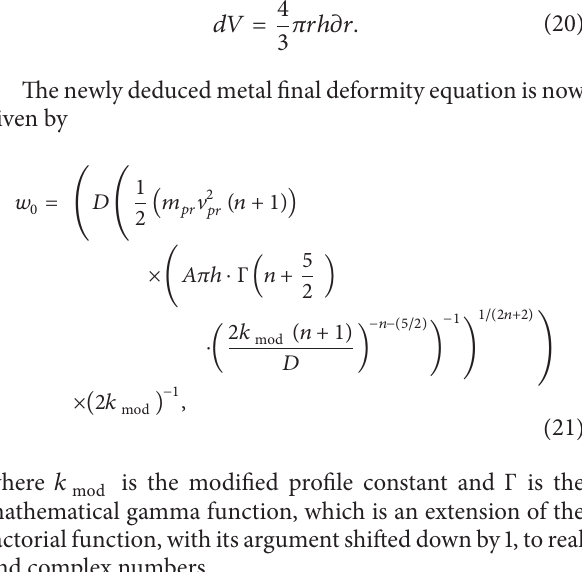
Table 1: Properties of the steel nucleus of the